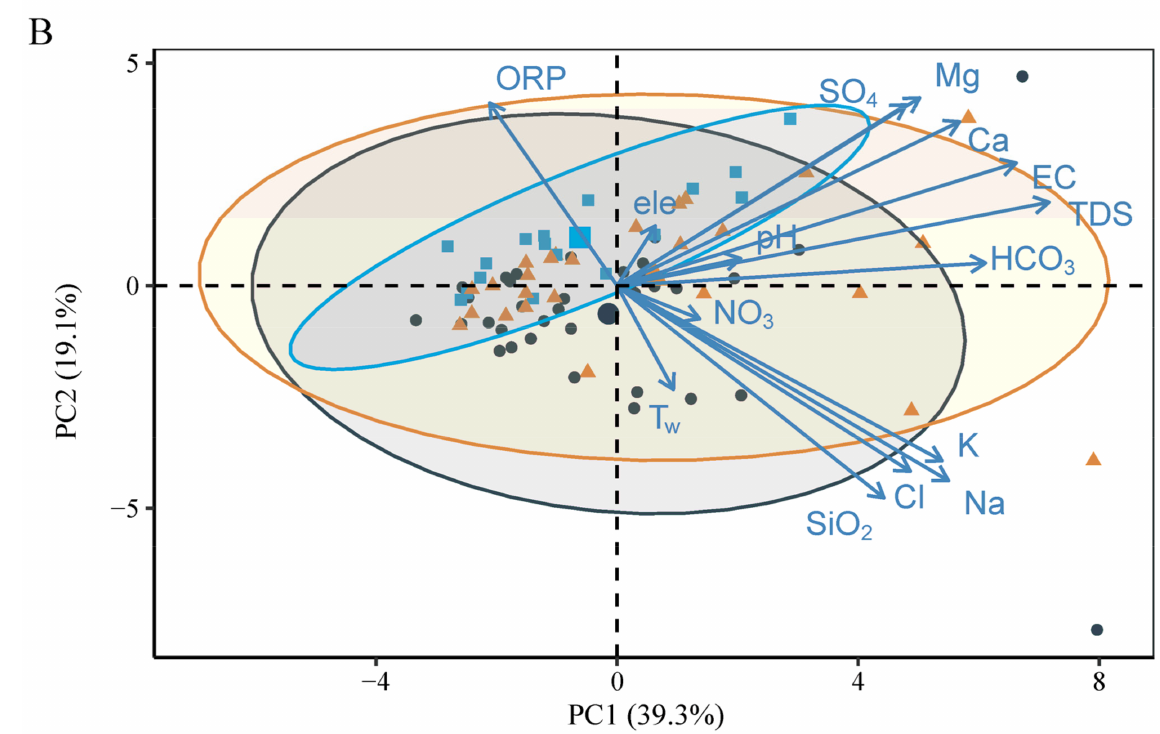
Figure 8. Biplot of the principal component analysis of the LR during the rainy season ( A ) and the dry season ( B